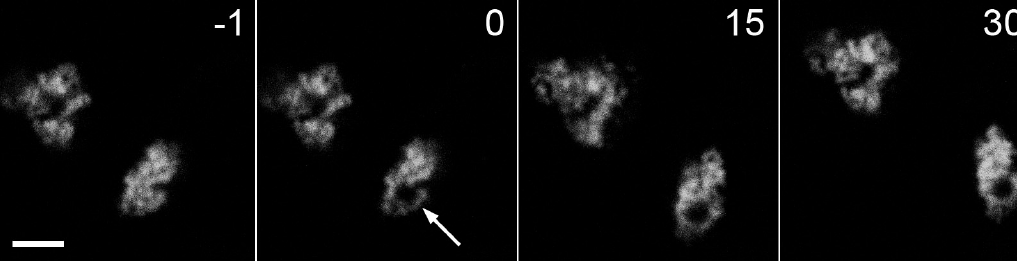
Figure 9. Even cytoplasmic distribution of expressing single-copy green FP AG4 ( A ) and four tandem copies of red FP E57 in HeLa Kyoto cells ( B ). Scale bar, − 20 µm.